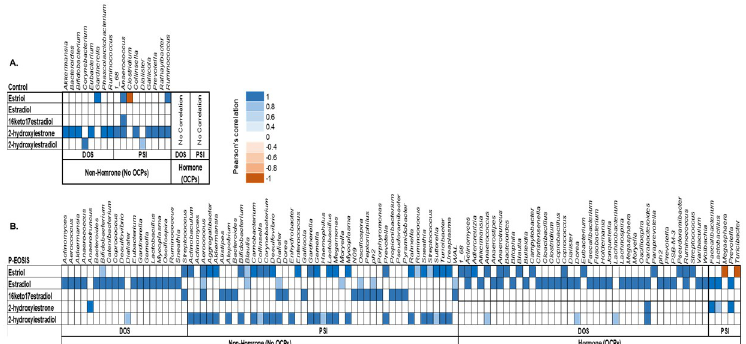
Fig 6. Pearson’s correlation coefficient between GI bacterial communities and the levels of urinary estrogens and their metabolites. All subjects were either receiving or not receiving hormonal treatment (OCPs). A . Control patients; B . Patients with endometriosis (P-EOSIS).